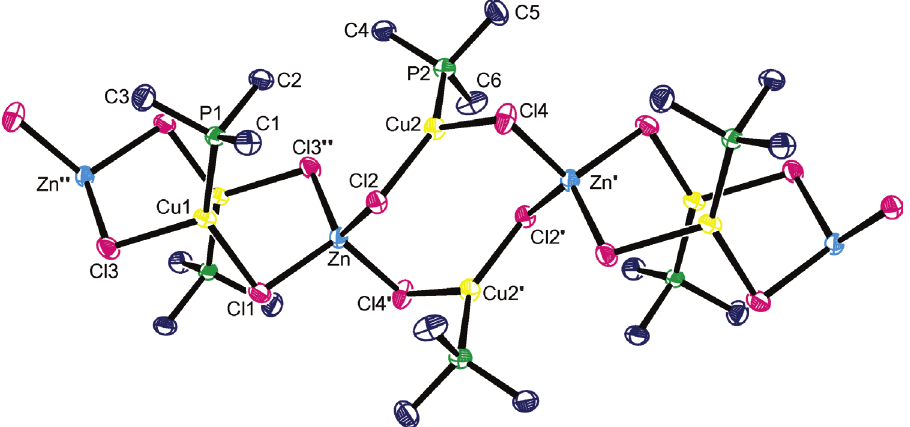
Figure 2 The asymmetric unit of 2 showing the labeling scheme used. Thermal ellipsoids are at the 40% probability level; hydrogen atoms have been omitted for clarity. Selected geometric data: Zn-Cl(1) 2.2927(6), Zn-Cl(2) 2.2885(6), Zn-Cl(3 ″ ) 2.2563(6), Zn-Cl(4 ′ ) 2.2547(6), Cu(1)-P(1) 2.1913(6), Cu(1)-Cl(1) 2.2688(6), Cu(1)-Cl(3) 2.3710(6), Cu(2)-P(2) 2.1772(6), Cu(2)-Cl(2) 2.2639(6), Cu(2)-Cl(4) 2.3849(6) Å; Cl(1)-Zn-Cl(2) 106.16(2), Cl(1)-Zn-Cl(3 ″ ) 108.57(2), Cl(1)-Zn-Cl(4 ′ ) 108.46(3), Cl(2)-Zn-Cl(3 ″ ) 111.85(2), Cl(2)-Zn-Cl(4 ′ ) 108.89(2), Cl(3 ″ )-Zn-Cl(4 ′ ) 112.64(3), P(1)-Cu(1)-Cl(1) 139.36(2), P(1)-Cu(1)-Cl(3) 117.88(3), Cl(1)-Cu(1)-Cl(3) 102.42(2), P(2)-Cu(2)-Cl(2) 142.64(2), P(2)-Cu(2)-Cl(4) 116.43(3), Cl(2)-Cu(2)-Cl(4) 100.85(2), Cu(1)-Cl(1)-Zn 96.04(2), Cu(2)- Cl(2)-Zn 103.99(2), Zn ″ -Cl(3)-Cu(1) 100.86(2), Zn ′ -Cl(4)-Cu(2) 93.02(2) ° . Symmetry operations: ( ′ ) 1- x , 1- y ,1- z ; ( ″ ) 1- x , - y , 1- z